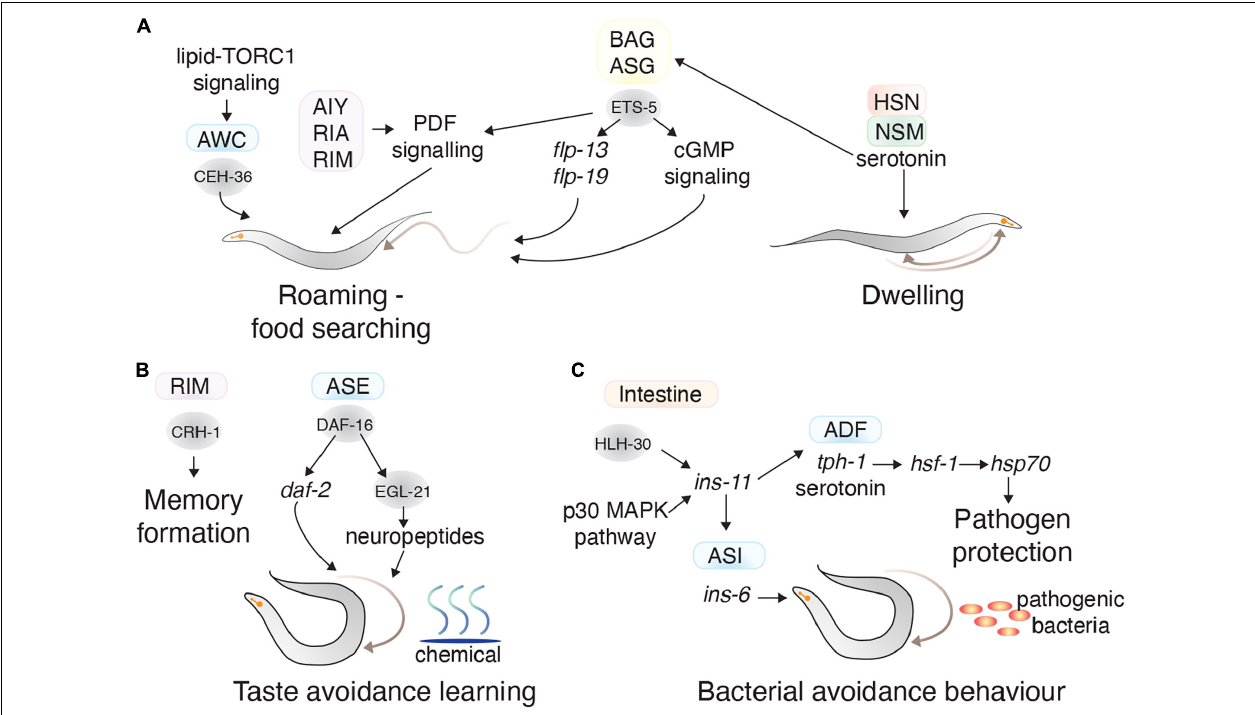
FIGURE 5 | Transcription factors in learning and complex behaviors. (A) The TFs (gray circles) and neurons (colored squares) involved in regulating food seeking behavior. CEH-36 in the AWC and ETS-5 in the BAG promote roaming behavior, whereas serotonin secretion from the HSN and NSM promote dwelling behavior. (B) The TFs (gray circles) and neurons (colored squares) involved in memory formation and taste avoidance learning. (C) The activity of TFs in distal tissues also regulate behavior. HLH-30 and p30 MAPK pathway in the intestine impact bacterial avoidance behavior by regulating ins-11 . This neuropeptide regulates ins-6 in the ASI neurons and serotonin in the ADF neurons, which regulate bacterial avoidance